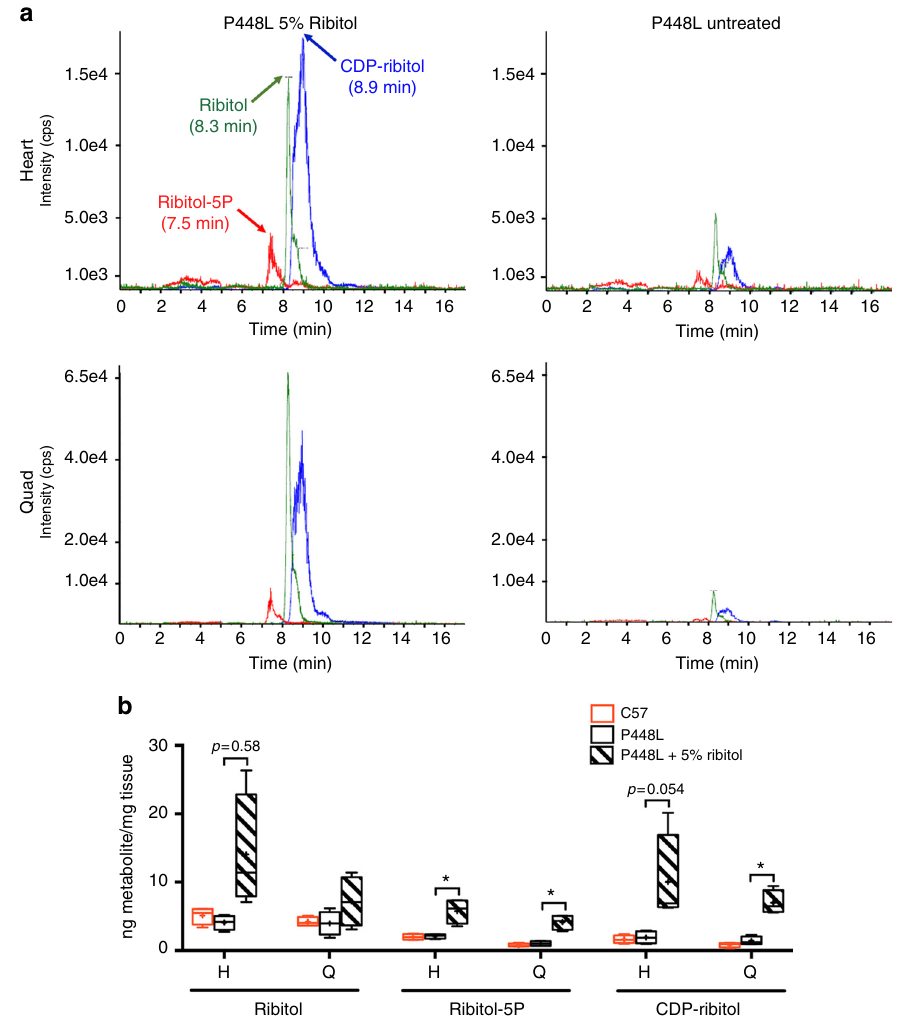
Fig. 2 Detection and quanti fi cation of ribitol, ribitol-5P, and CDP-ribitol by LC/MS-MS. a LC/MS-MS detection of ribitol, ribitol-5P, and CDP-ribitol from heart and quadriceps of 4-week-old P448L mice treated with drinking water only (untreated) or water supplemented with 5% ribitol for 1 month. b Quanti fi cation of ribitol, ribitol-5P, and CDP-ribitol levels by LC/MS-MS from heart (H) and quadriceps (Q) of untreated and 5% ribitol-treated P448L mice, and untreated C57 control mice ( n = 4 for all cohorts). Box represents 25th and 75th percentiles. Line represents median and “ + ” represents mean. Whiskers extend from min to max value. Unpaired t test, * p ≤